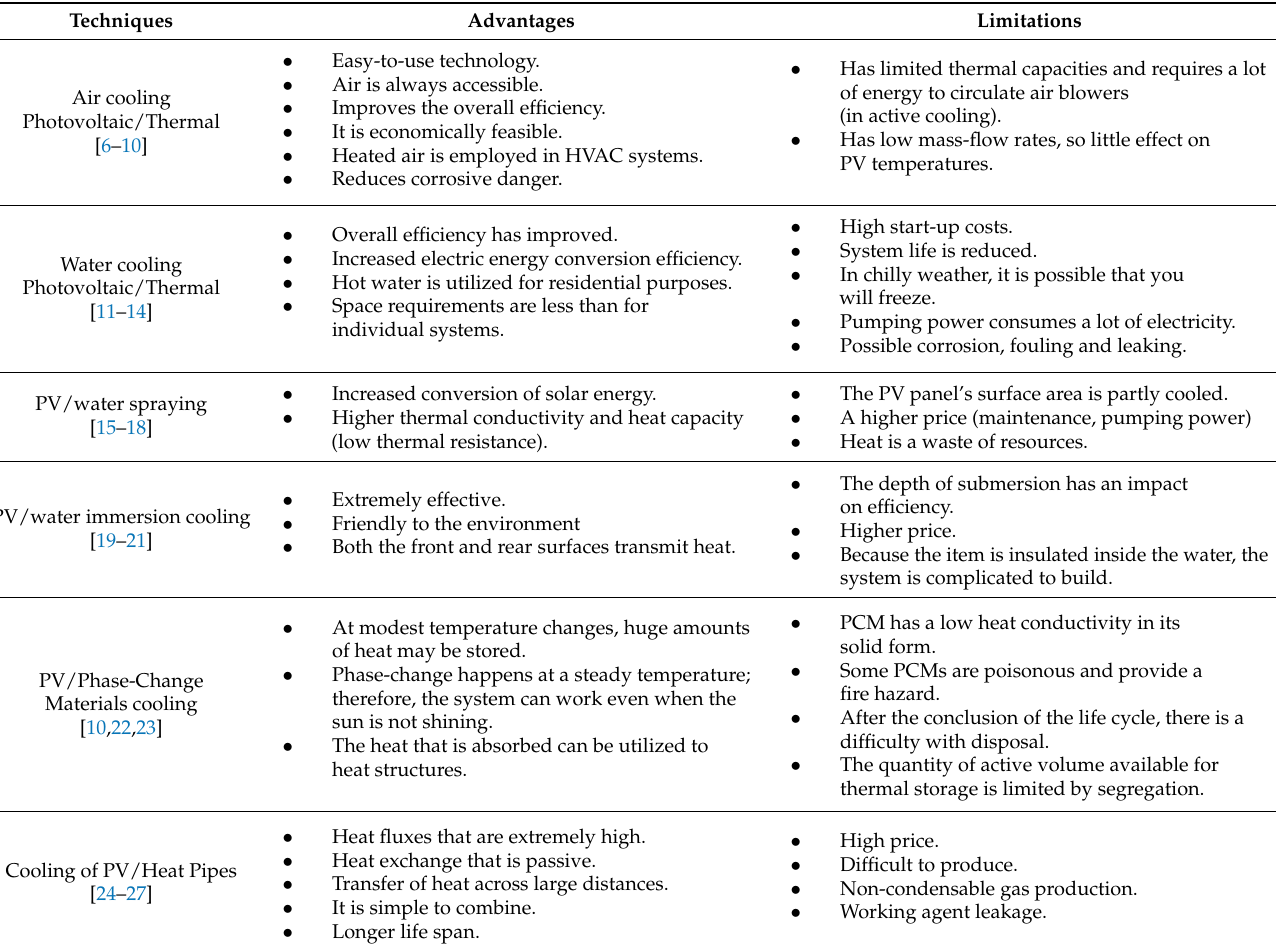
Table 1. Photovoltaic cooling